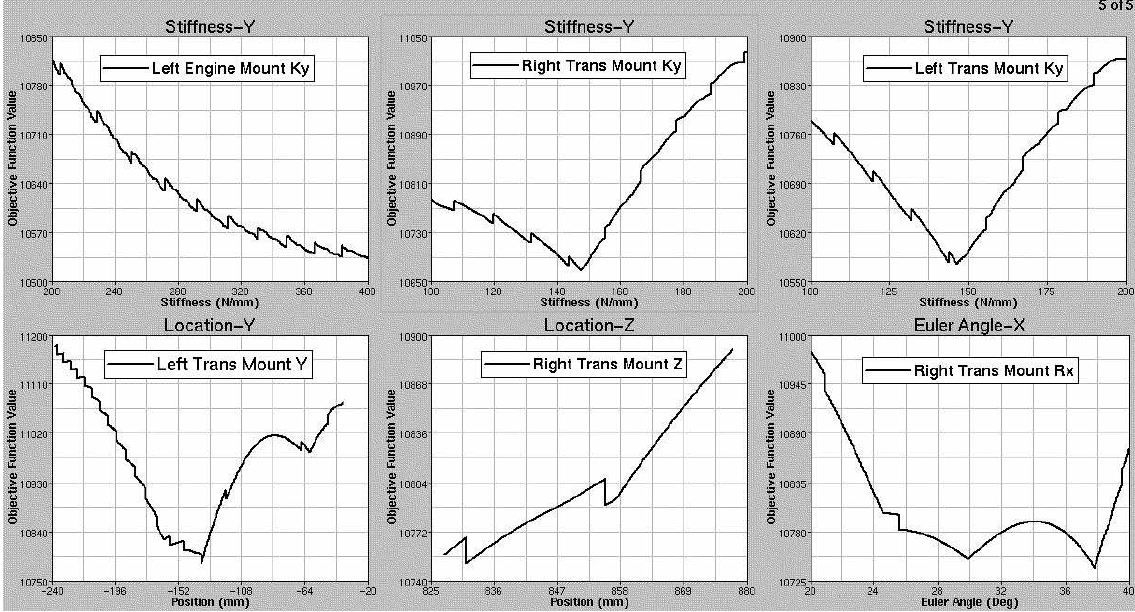
Fig. 4. In this figure, the non-linear, discontinuos and multi-modal nature of the response surface is quite